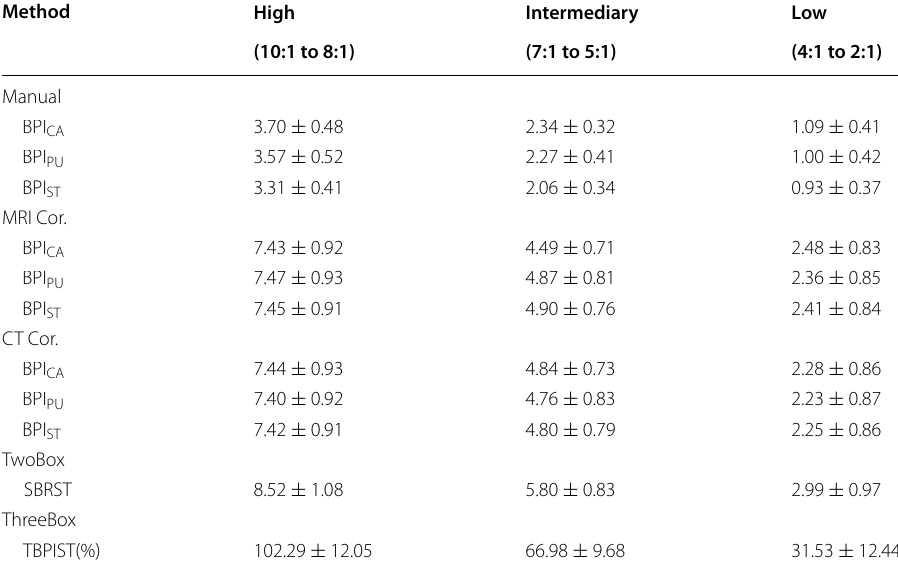
Table 2 Semi‑quantification results to any method applied on different structures of the striatum phantom. The indexes of quantification are represented for Binding Potential Index (BPI); Specific Binding Ratio (SBR) and Total Binding Potential Index (TBPI) in the quantification of cavities simulated of the caudate nucleus, putamen and striatum Index of Quantification Measured to Different Levels Activity Concentration in Striatum Phantom(Mean